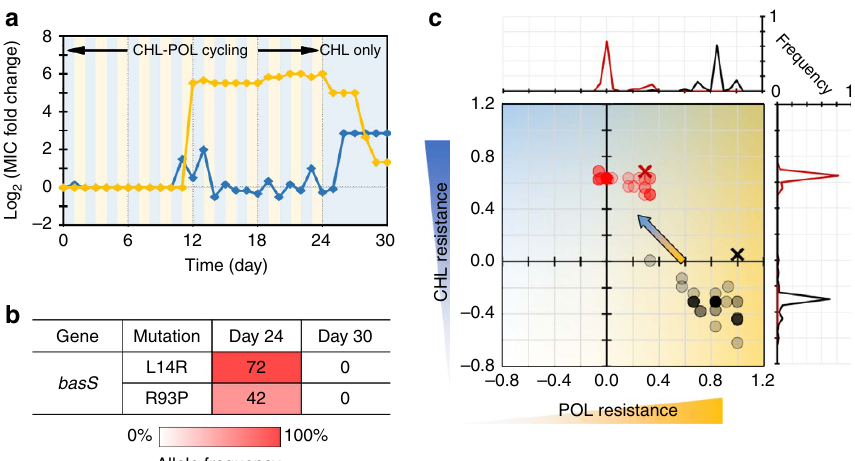
Figure 5 | Reversal of evolved drug resistance with counteracting antibiotic. ( a ) Evolutionary trajectories of POL and CHL resistance (yellow and blue, respectively). The background colours indicate the antibiotics used. ( b ) Allele frequencies of basS gene. Numbers in the map indicate the frequency of mutants in the populations, estimated from gene sequencing analysis. ( c ) Scatter plot of MICs of single isolates for day 24 and 30 (black and red circles, respectively). Samples sizes are n ¼ 70 for both cases. Darker colour corresponds to higher frequency. The MIC of a whole population is shown as a black or red cross,